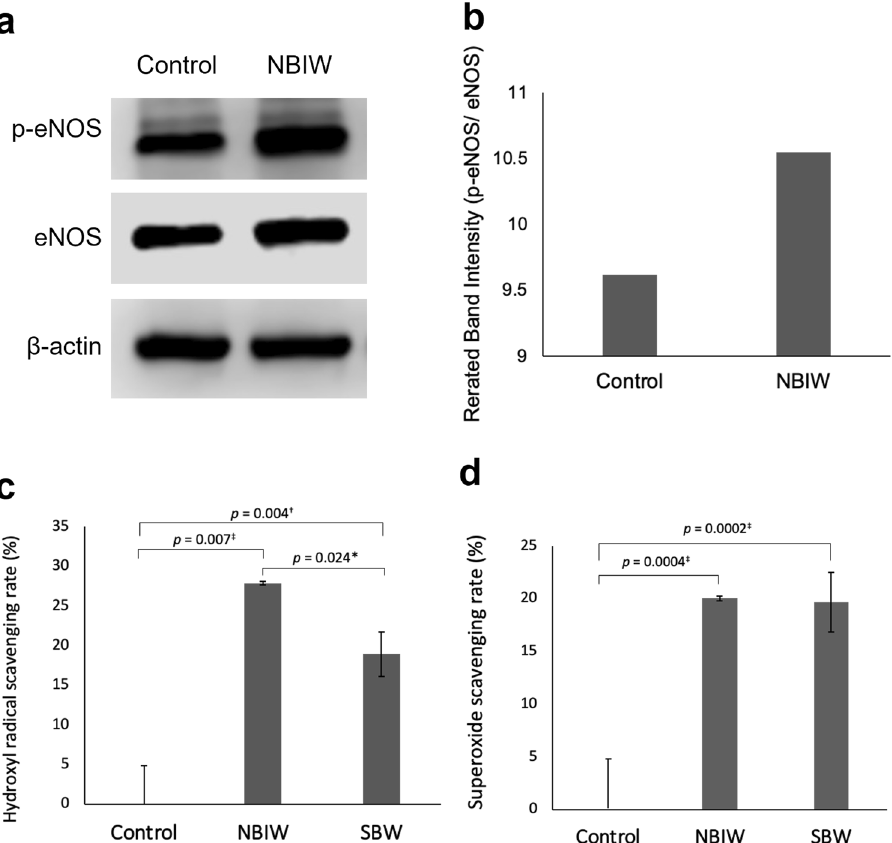
Figure 2. Effect of neutral bicarbonate ion water in human umbilical vein endothelial cells. ( a , b ) Effect of neutral bicarbonate ion water (NBIW) in human umbilical vein endothelial cells (HUVEC). HUVEC were serum starved for 6 h, NBIW equivalent to a bicarbonate ion level of 2.5 ppb was added in culture medium, and the cell lysate was analyzed 5 min later. ( a ) Typical example of Western blotting showing endothelial nitric oxide synthase (eNOS) and phospho-eNOS (p-eNOS) levels. The protein carried per lane was 20 μg. The β-actin blot is from a different part of the gel blotted with p-eNOS. eNOS was reblotted onto the membrane blotted with p-eNOS. The full blot is provided in the Supplementary Information. ( b ) eNOS phosphorylation level in cells was higher in cells exposed to NBIW than in those exposed to the control solution. ( c , d ) Reactive oxygen species (ROS) scavenging activity of NBIW. Hydroxy radical scavenging ability of NBIW was determined by electron spin resonance (ESR). The mean ( SD ) scavenging rate for a hydroxy radical generated by ultraviolet irradiation/hydroxy peroxide solution was 0.0 (4.85) for ultrapure water (control), 27.9 (0.21) for NBIW, and 18.9 (2.81) for sodium bicarbonate water without citric acid (SBW). The mean ( SD ) superoxide scavenging rate was 0.0 (2.61) for control, 20.0 (0.66) for NBIW, and 19.7 (1.74) for SBW. Each condition was repeated 3 times and analyzed by Student’s or Welch’s t-test. *p < 0.05, † p < 0.01, ‡ p < 0.005.